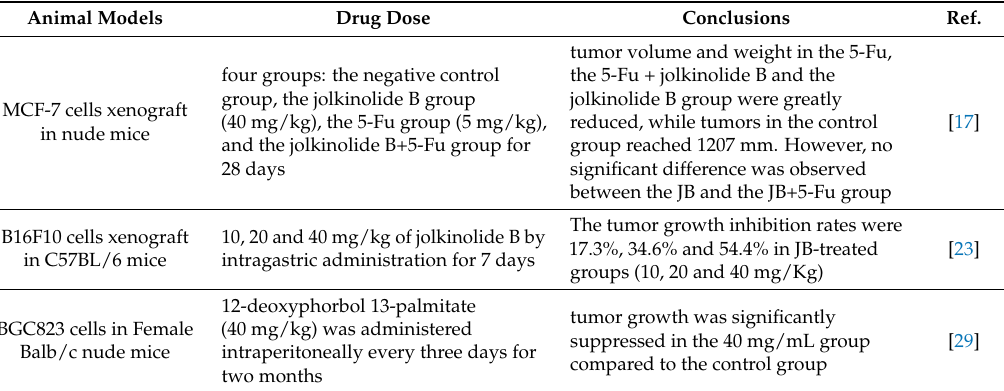
Table 3. The in vivo antitumor effects of other compounds need to be tested in future experiments. Table 3. Summary of the anticancer activities of diterpenoids in